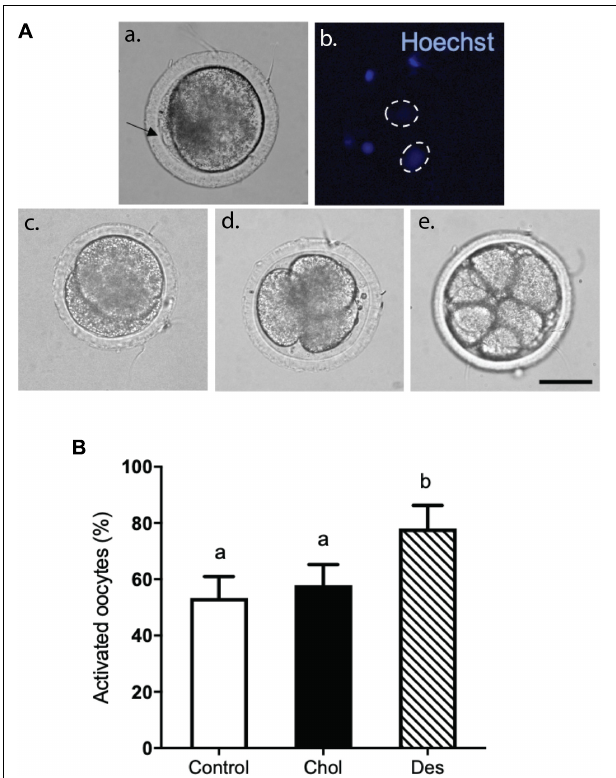
FIGURE 6 | Effect of sterol incorporation on the ability of cryopreserved ram sperm to activate bovine oocytes in vitro . (A) Different hybrid cleavage stages of activated bovine oocytes after heterologous IVF with cryopreserved ram sperm pretreated with 10 mM M β CD-Chol (Chol) or -Des (Des). After co-incubation with sperm, oocytes were fixed and stained with Hoechst 33342. (a) Bright field of inseminated oocyte. The arrow shows polar bodies and adhered sperm to zona pellucida . (b) Oocyte pronuclei stained with Hoechst 33342 denoted by dashed circles and hybrid embryos with two (c) three (d) and eight cells (e) . Scale bar: 50 µ m. (B) Activation rate after heterologous IVF. Results are shown as percentages of activated oocytes and represent mean values ± SEM of 5 independent experiments from a total of 205 control oocytes, 199 M β CD-Chol treated oocytes and 189 M β CD-Des treated oocytes. Data were analyzed using Generalized Linear Mixed Models (GLMM) with Binomial family. The different letters (a, b) indicate significant differences ( p <